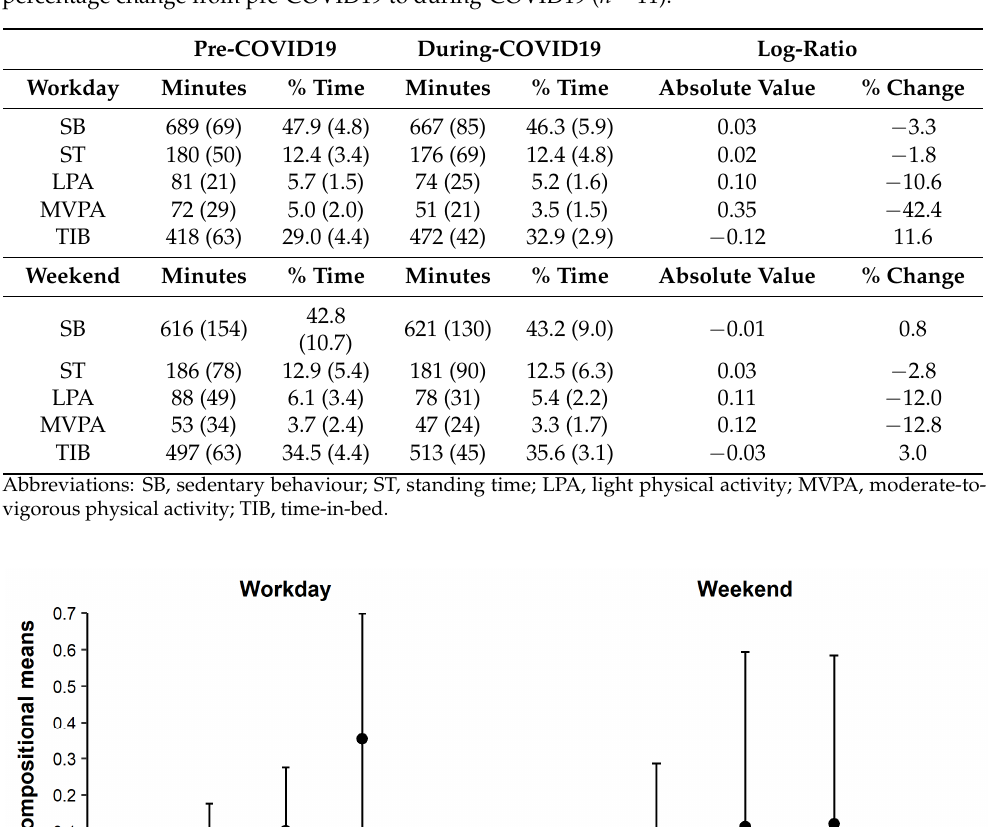
Table 2. Compositional mean (with SD between participants) in minutes per day and percentage of time of each behaviour pre-COVID19 and during-COVID19, for both workdays and weekends; as well as the log-ratio of compositional means pre-COVID19 vs. during-COVID19, and the corresponding percentage change from pre-COVID19 to during-COVID19 ( n = 11).